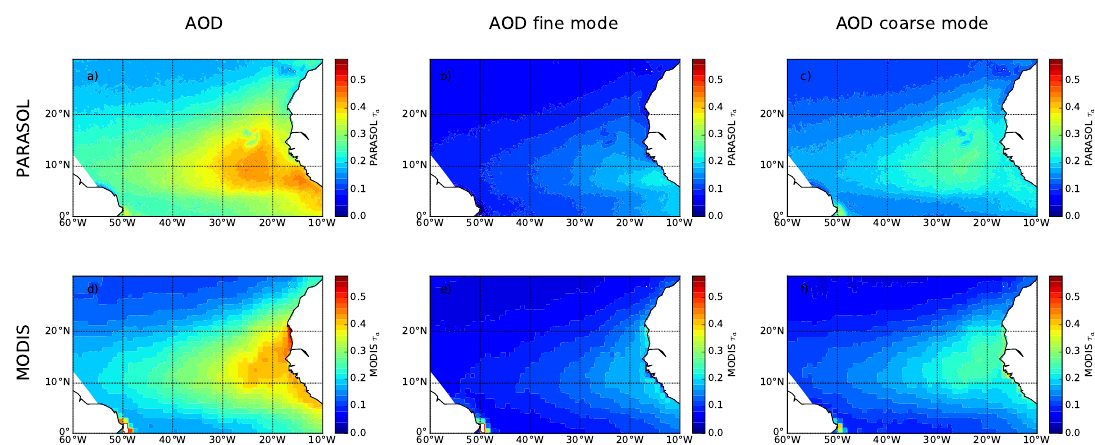
Figure 6. Spatial distribution of the total AOD (left column), AOD f (central column) and AOD c (right column) observed by PARASOL satellite (top figures ( a – c )) and MODIS satellite (bottom figures ( d – f )) at 550 nm averaged from 2005 to 2013. Note that the Level-3 MODIS Atmosphere Monthly Global Product MYD08_M3 collected from the Aqua platform (https://modis-atmos.gsfc.nasa.gov/products/monthly) has been